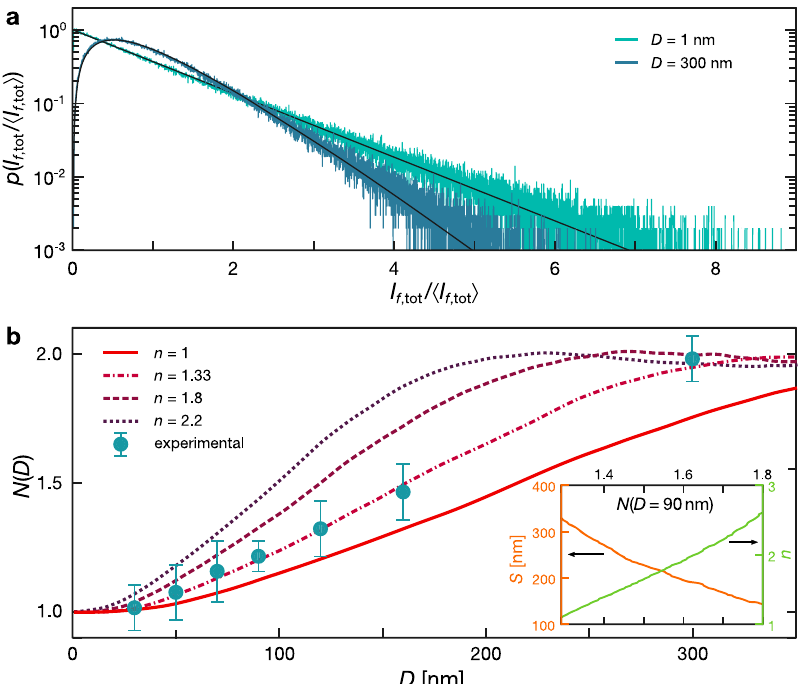
Fig. 2 Dependence of the probability density of the intensity on nanoruler size: homogeneous medium. a Numerically calculated probability density function obtained for D = 1 and 300 nm in a homogeneous medium with n = 1.33. Solid lines represent Eq. (1) with N = 1 and N = 2. b Numerically retrieved N ( D ) curves for different refractive indices. The experimental data is shown as full circles with an uncertainty estimated by averaging the results over 12 different nanorulers embedded in two different samples, independently for each value of D . The inset shows the relation between n and S as determined numerically for a nanoruler of size D = 90